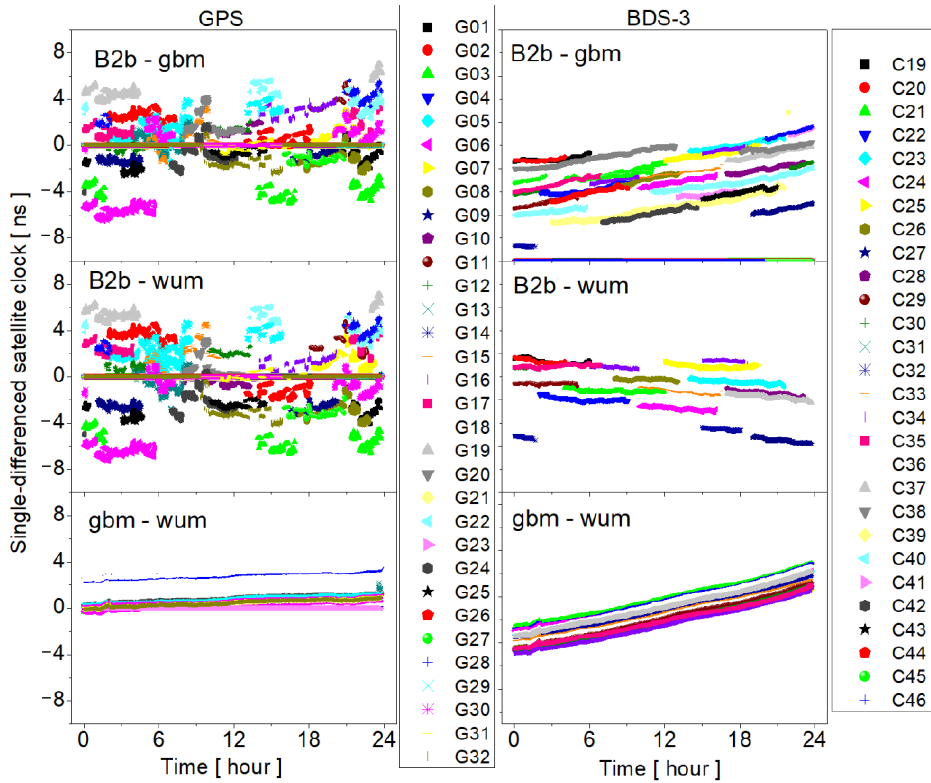
Figure 1. Single-differenced satellite clock series between different products in MJDN 59100 (8 Sep- tember 2020); B2b, gbm, and wum represent products of PPP-B2b, GFZ, and WHU.